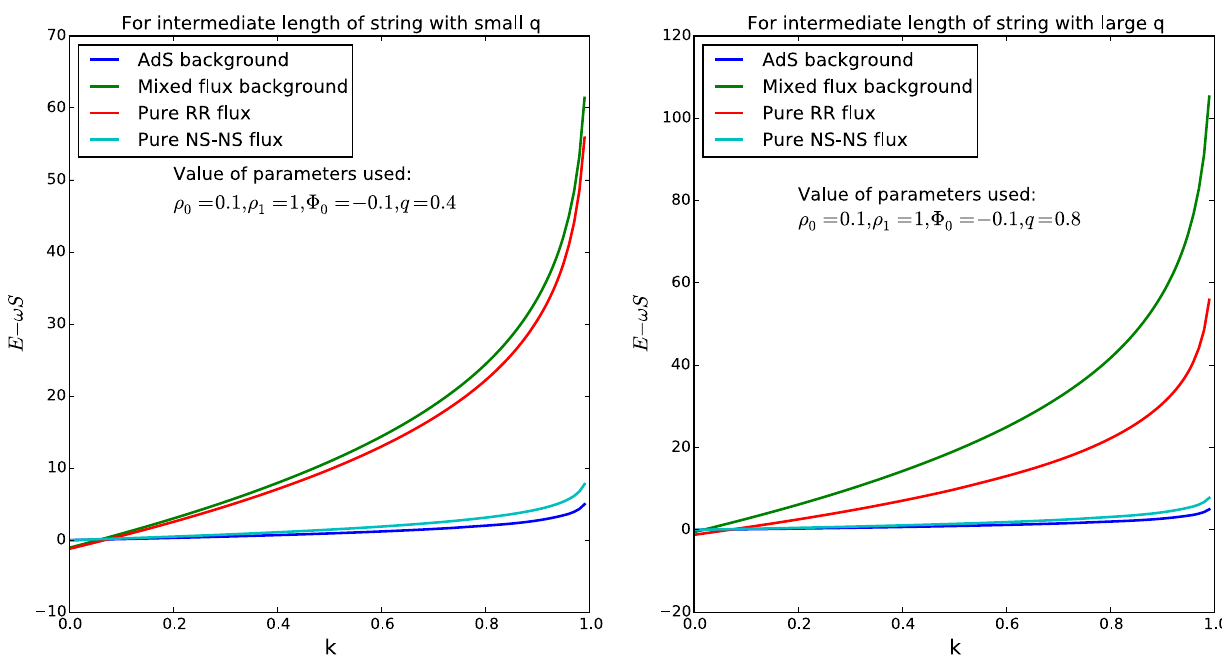
Fig. 6 In this figure the spin-energy relation E − ω S has been plotted against k for different backgrounds under intermediate length of the string. It seems that the pure NS-NS flux spin-energy relation following the spin-energy relation of AdS and these curves are independent of quite different tracks